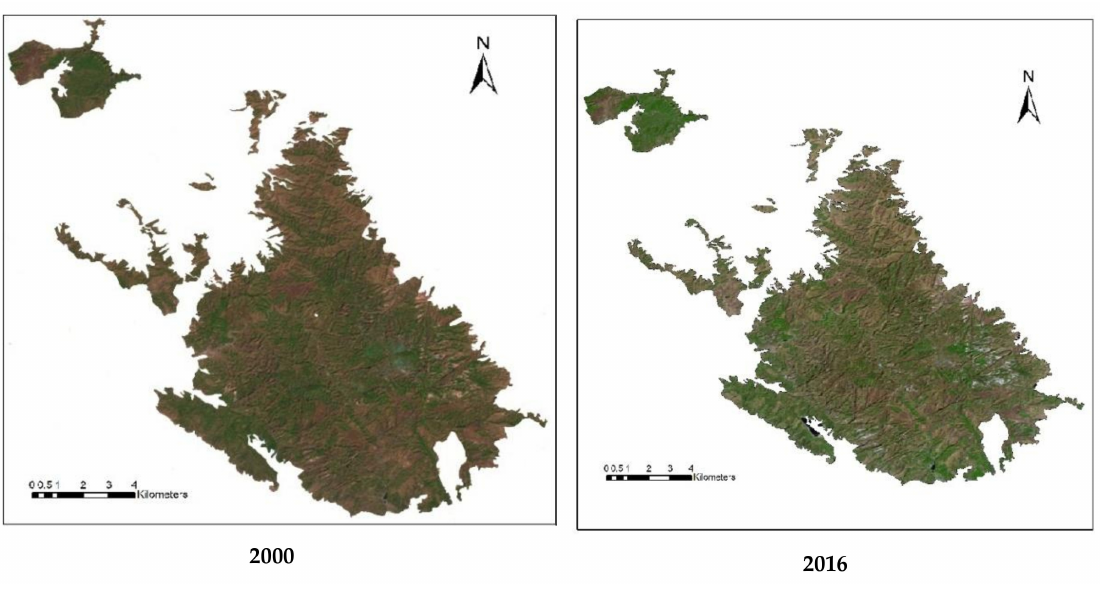
Figure 4. Illumination corrected